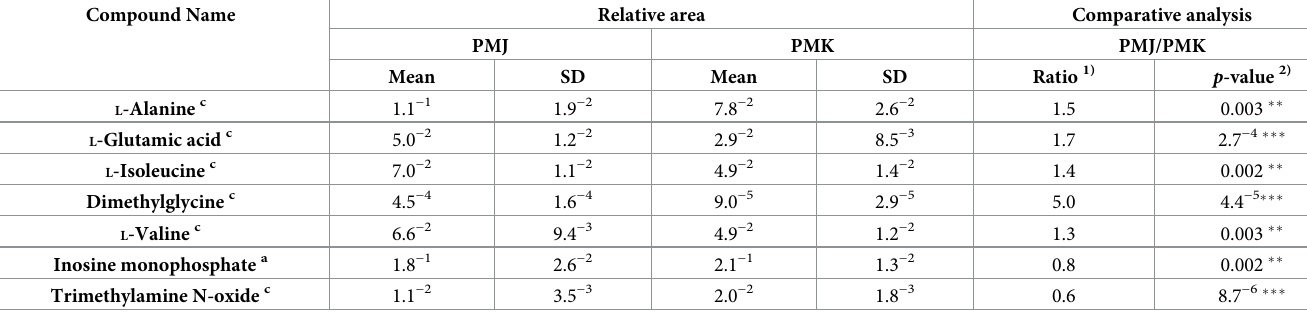
Table 3. Differences in the main compounds between South Korean and Japanese red seabream